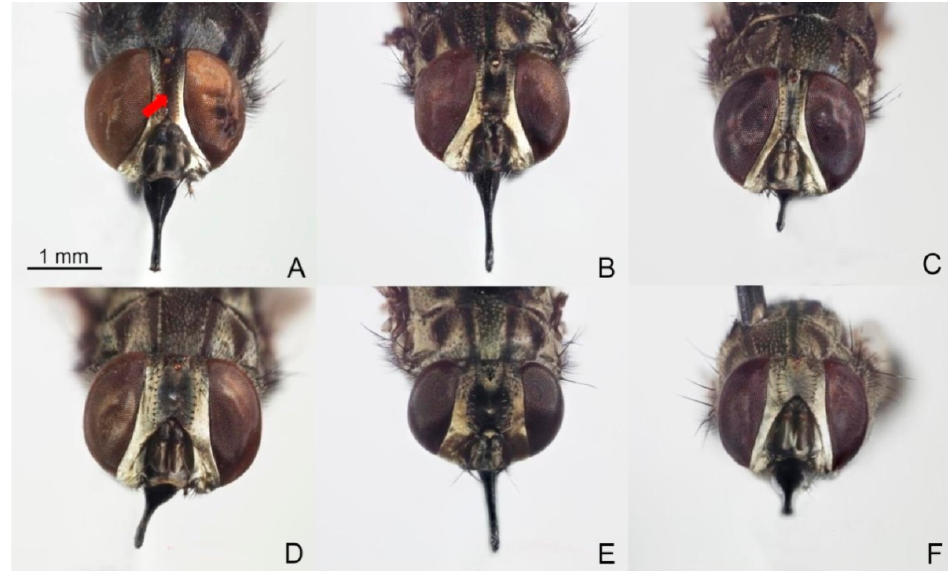
Figure 2. Male and female heads of Stomoxys bengalensis ( A , D ), S. calcitrans ( B , E ), and S. sitiens ( C , F ). The width of frons (arrow) is used to distinguish among species. Photos are made by authors.